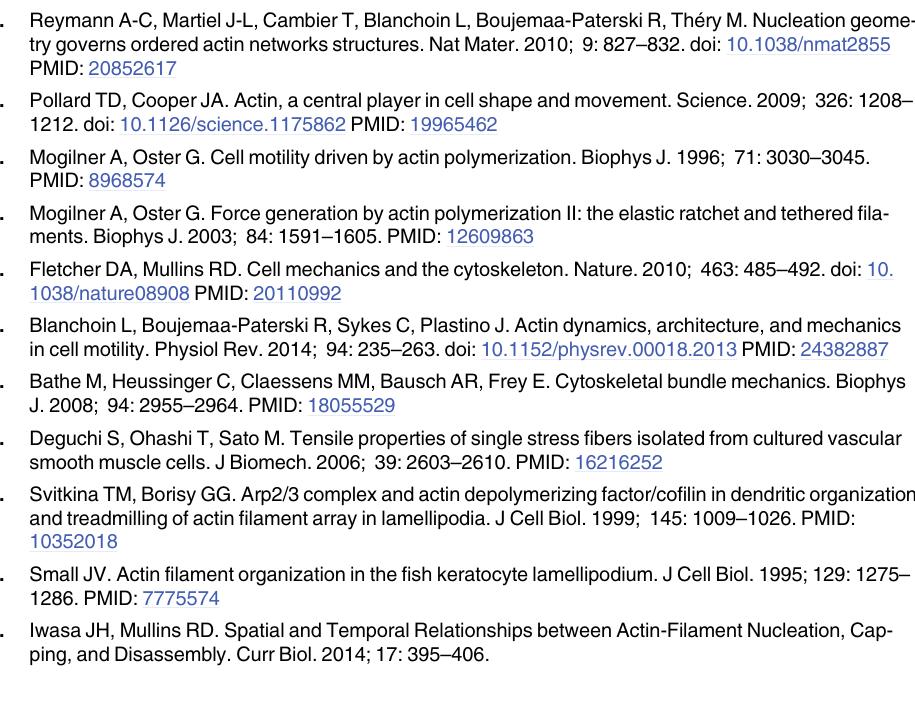
S1 Table. Main parameters used in the